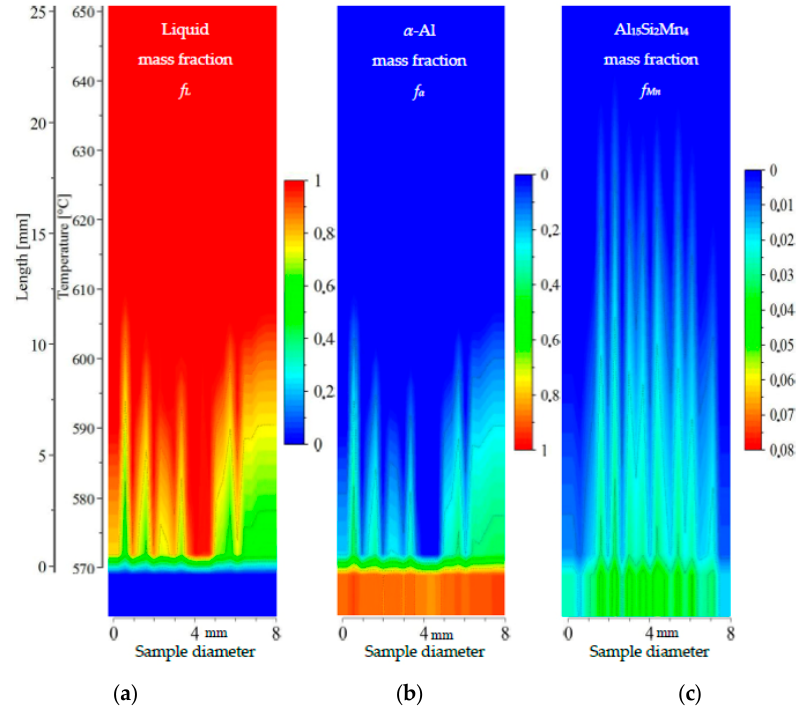
Figure 13. 2D maps of mushy zone for AlSi9Mn1.0 specimen: ( a ) liquid mass fraction f L ; ( b ) α -Al mass fraction f α ; ( c ) Al 15 Si 2 Mn 4 mass fraction f Mn in function of sample diameter and temperature/sample length.